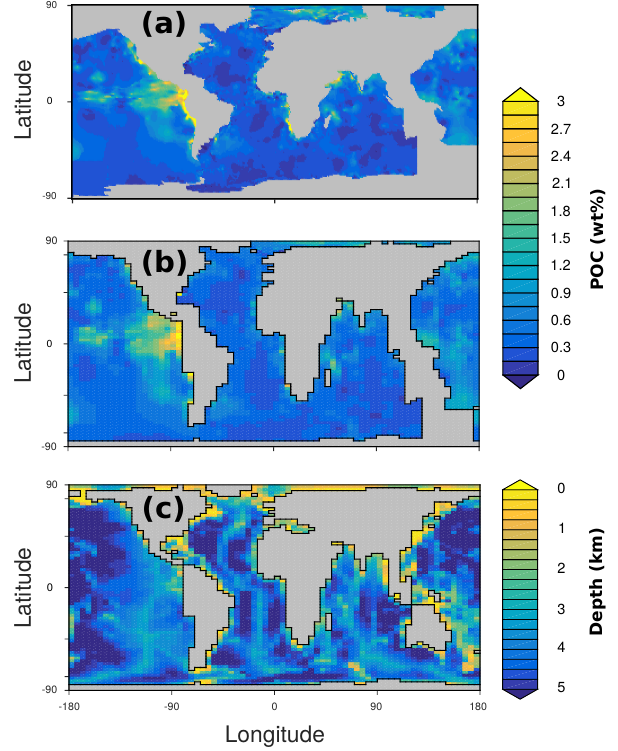
Figure 11. Observed distribution of sediment surface ( < 5cm) POC wt% (a, b) and cGENIE bathymetry (c) . (a) Original global distri- bution of POC wt% interpolated on a 1 ◦ × 1 ◦ grid from more than 5500 individual data points (compare to Seiter et al., 2004, for the interpolation procedure). (b) Observed POC wt% data transformed onto the 72 × 72 SEDGEM grid. Grid points without any observa- tions are left blank (grey). (c) Gridded continental configuration and ocean bathymetry of the 16-level, 72 × 72 equal-area cGENIE